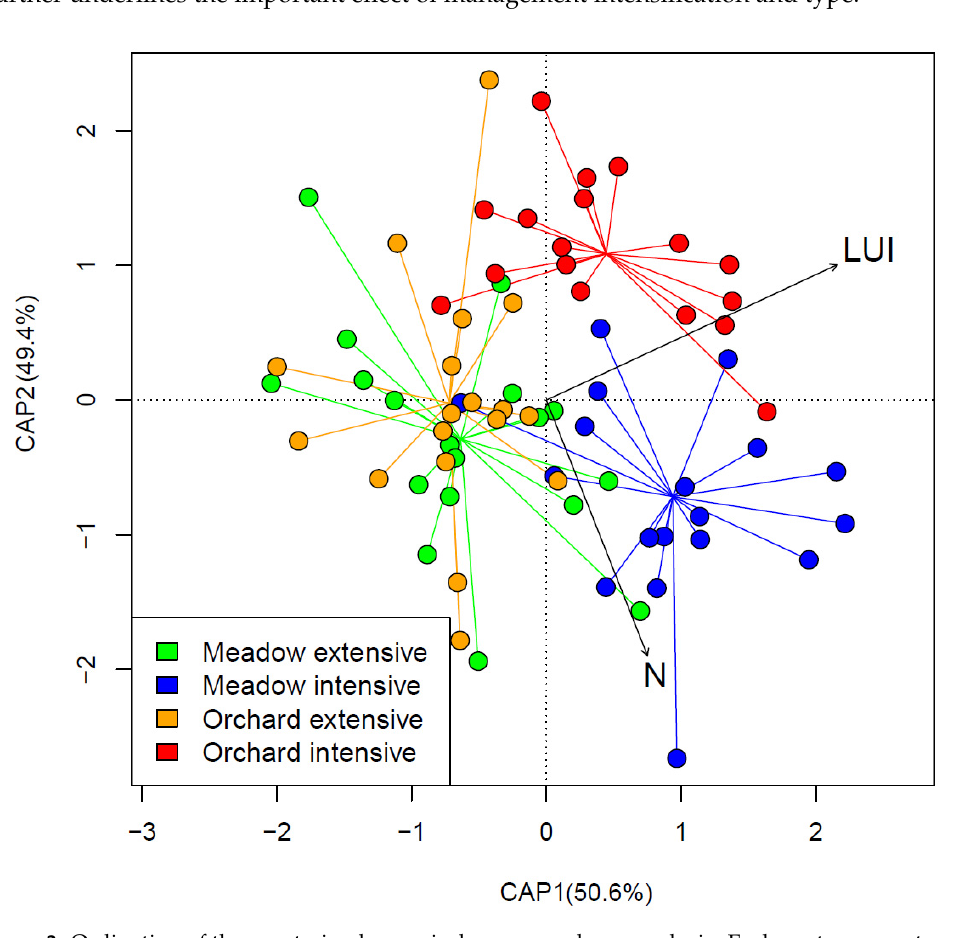
Figure 3. Ordination of the constrained canonical correspondence analysis. Each spot represents one sampling event per site. Colors and spider webs according to the field management type. Spider web centers are the weighted centroids of each management type.